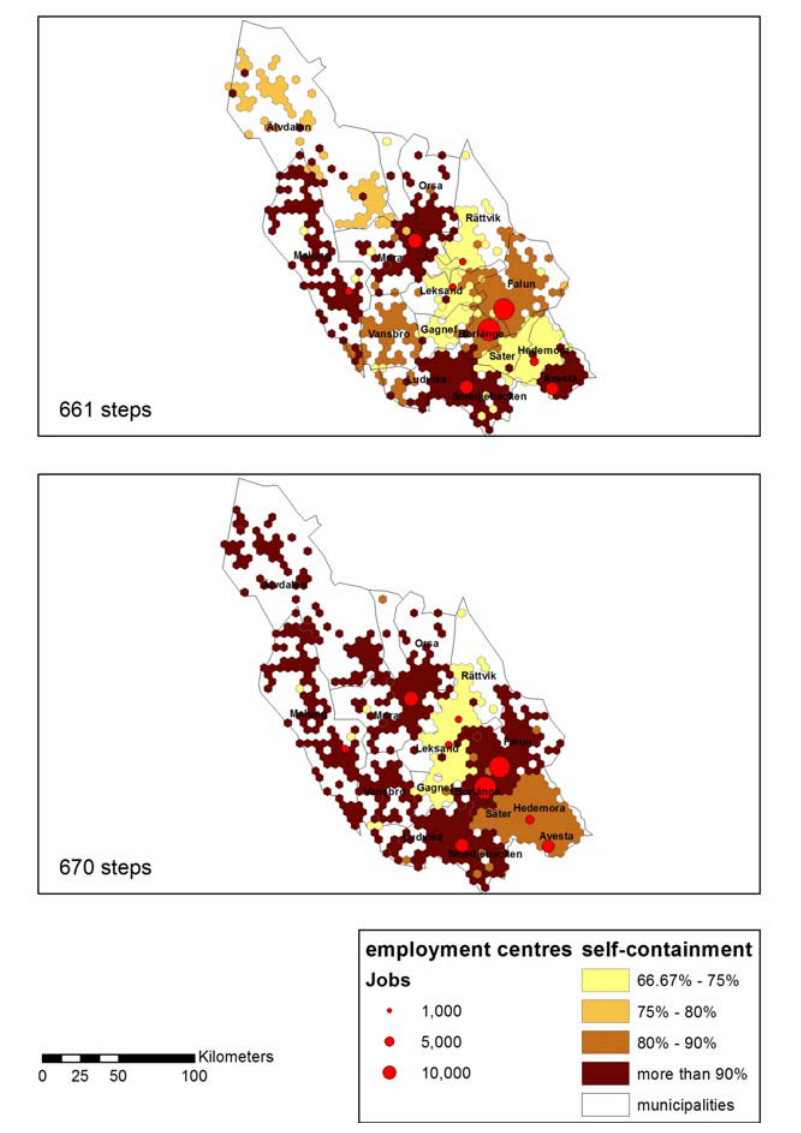
Figure 6. Residence-based self-containment at steps 661 (11 regions) and 670 (six